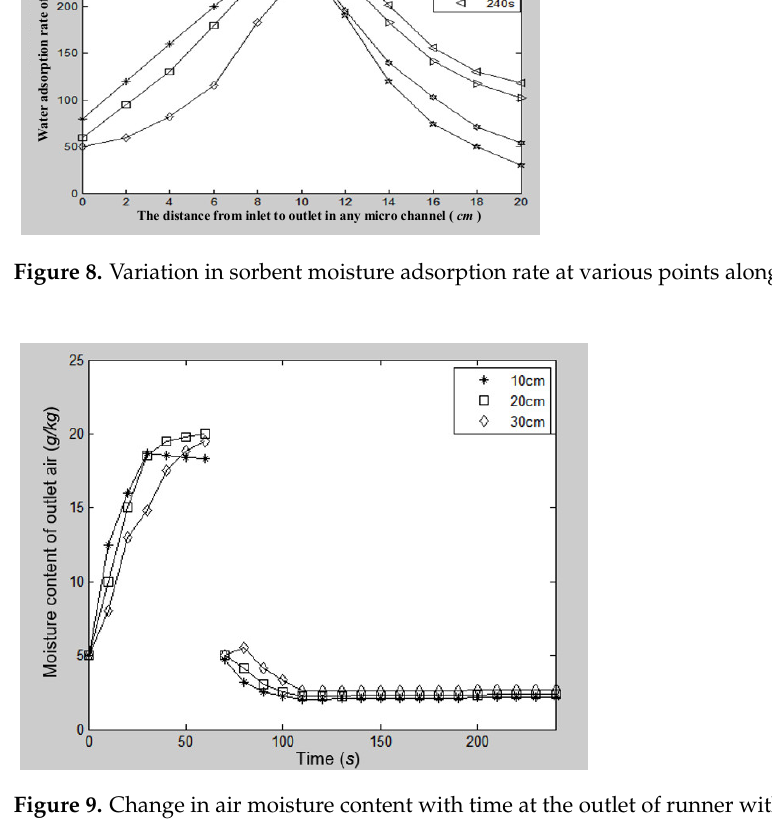
Figure 8. Variation in sorbent moisture adsorption rate at various points along the channel direction.